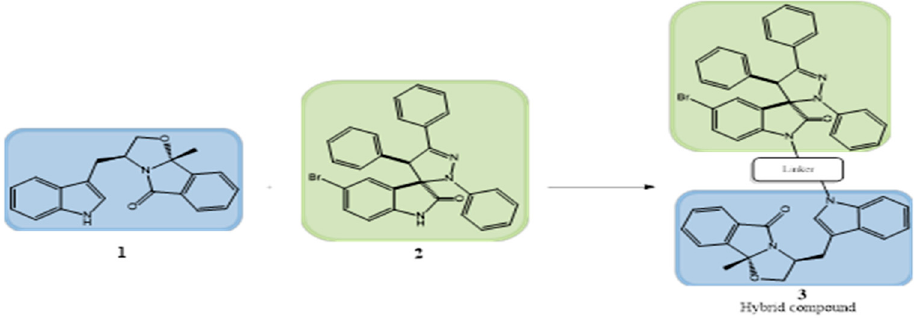
Figure 1. Synthetic approach for the synthesis of the hybrid Figure 27. Synthetic approach for the synthesis of the hybrid compounds.